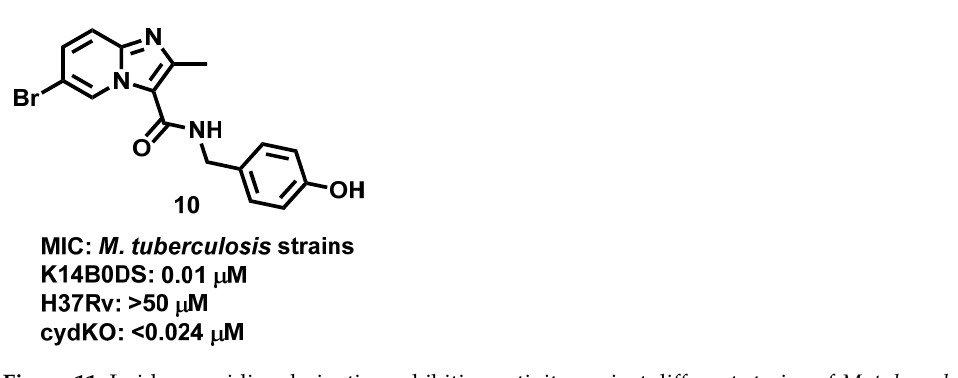
Figure 11. Imidazopyridine derivative exhibiting activity against different strains of M. tuberculosis. Signatures of compounds according to Arora et al., 2014 [65].